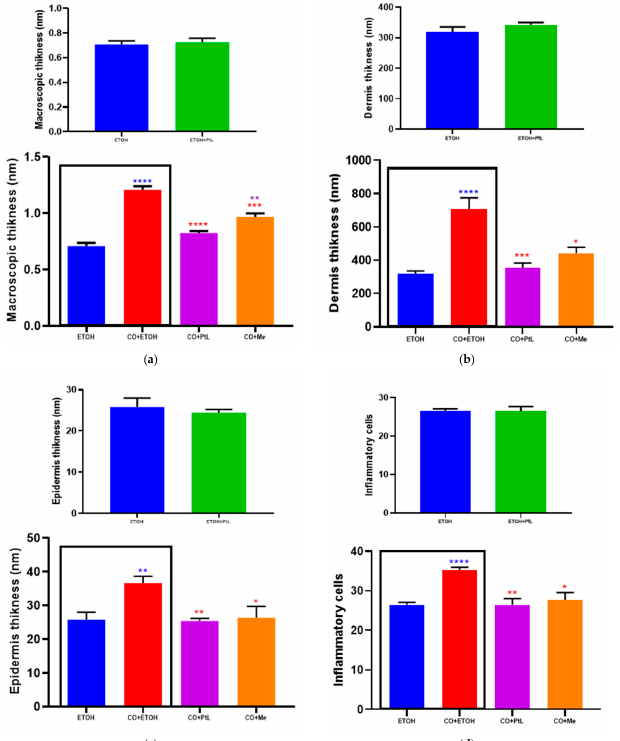
Figure 3. Changes in macroscopic ear ( a ), dermis ( b ) and epidermis thickness ( c ) and the number of inflammatory cells in the rats’ ears ( d ) after the croton oil challenge test. Differences between the ETOH and ETOH + PtL and the ETOH and CO + ETOH groups were assessed using a Student’s T-test, while differences between CO + ETOH, CO + PtL, and CO + Me were assessed using an one-way ANOVA. (ETOH: control animals, application of pure ethanol; CO + ETOH: croton oil 5% dissolved in pure ethanol; ETOH + PtL; application of P. tridentatum extract dissolved in pure ethanol; CO + Me: croton oil 5% dissolved in pure ethanol followed by application of Medrol 15 min later; CO + PtL: croton oil 5% dissolved in pure ethanol followed by application of P. tridentatum extract 15 min later). Results are expressed as mean ± SEM. Symbols are colored according to their respective experimental group. Results are expressed as mean ± SEM. * p < 0.05, ** p < 0.01, *** p < 0.001, **** p <